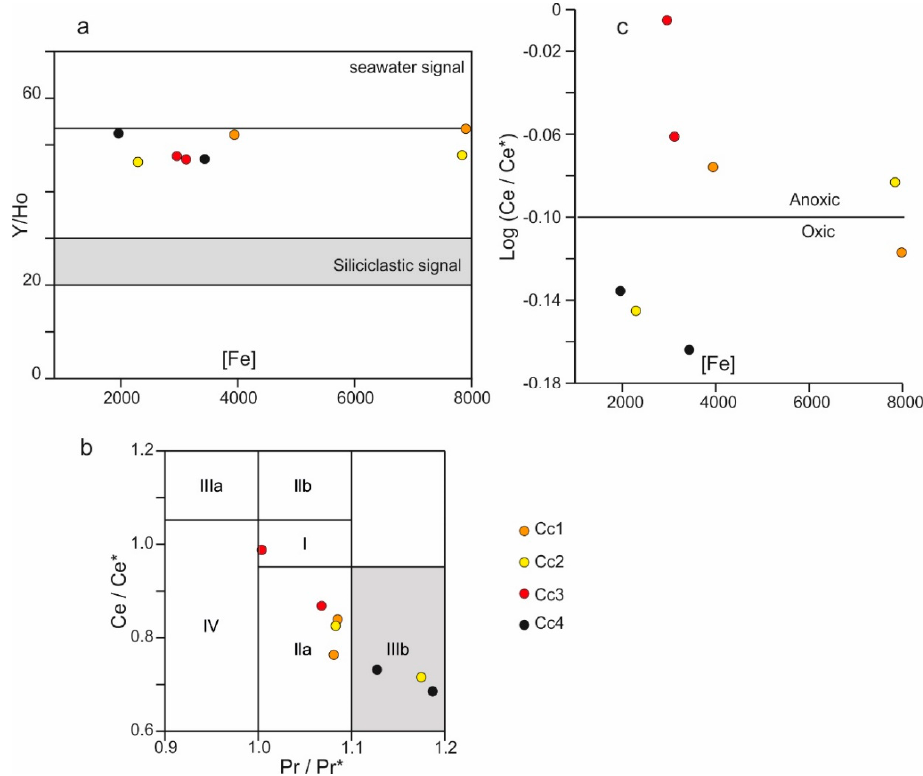
Figure 15. ( a ) Y/Ho ratios vs Fe content cross-plot for calcite cements Cc1 to Cc4. Y/Ho values for modern seawater and terrigenous sediments are based on [99,100]. ( b ) PAAS-normalized Ce/Ce * vs Pr/Pr * cross-plot showing the Ce and Pr anomalies of calcite cements Cc1 to Cc4. The method of [97] as modified by [101] is used. Field I: no anomaly; Field IIa: positive La anomaly and no Ce anomaly; Field IIb: negative La anomaly and no Ce anomaly; Field IIIa: positive Ce anomaly; Field IIIb: negative Ce anomaly; Field IV: positive Ce and La anomalies. ( c ) Log(Ce/Ce *) vs Fe content cross-plot of calcite